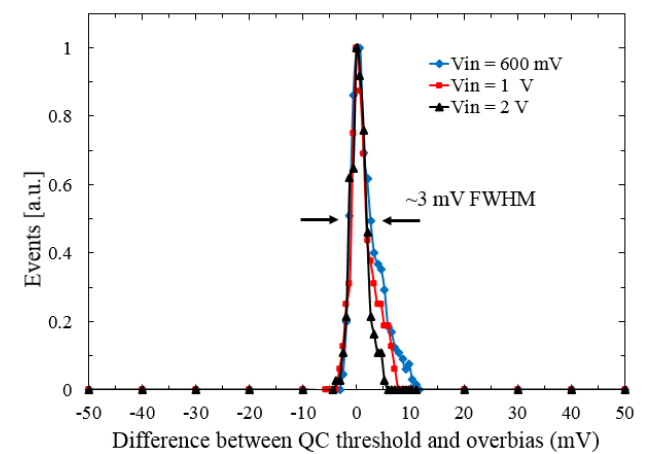
Figure 15. Derivative of the S-curve (Figure 14) of the discrimination showing a variation of about 3 mV FWHM of the electronics, without a SPAD.